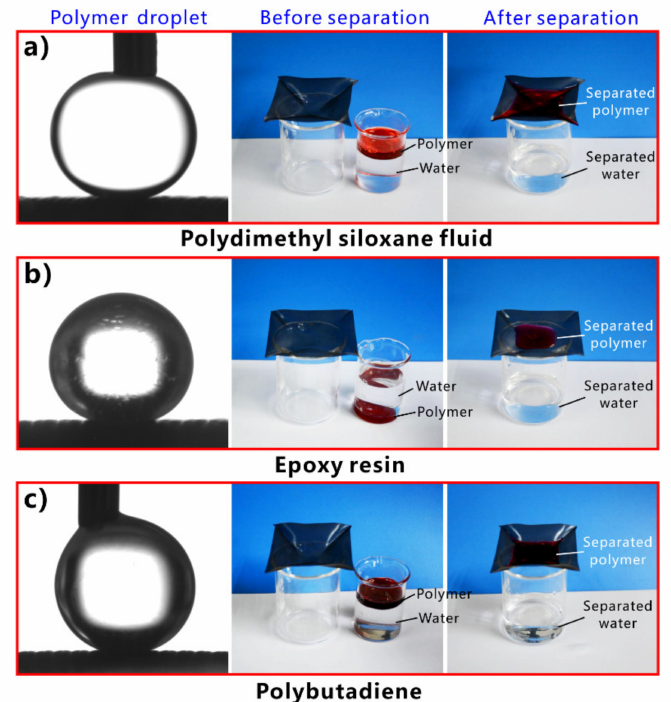
Figure 24. Separating different polymers from water by using an underwater superpolymphobic mesh: ( a ) polydimethylsiloxane fluid, ( b ) epoxy resin, and ( c ) polybutadiene. First column: an underwater droplet of liquid polymer on the structured mesh. Second column: before separation. Third column: after separation. Reprinted with permission from ref. [302]. Copyright 2020,